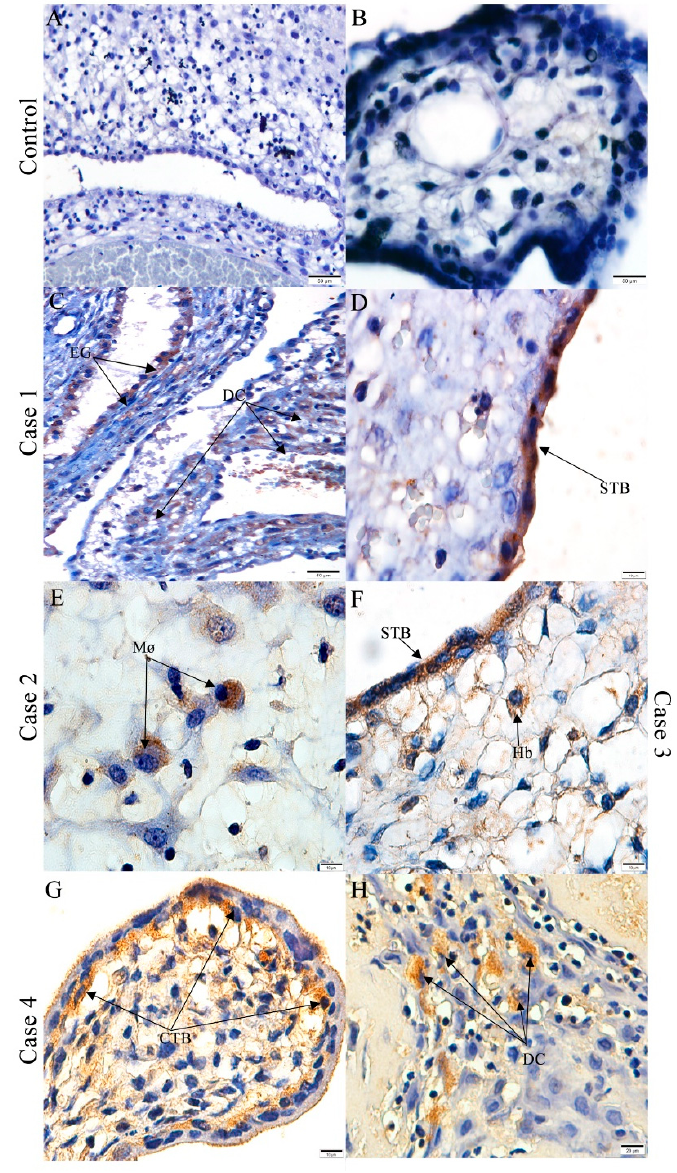
Figure 3. Detection of the chikungunya virus (CHIKV) antigens in aborted materials: Control aborted material without the detection of CHIKV in the ( A ) decidua and ( B ) chorionic villi. CHIKV detection in ( C ) cells of the endometrial glands (EG), decidual cells (DC) and ( D ) syncytiotrophoblasts (STB) of case 1; ( E ) decidual macrophages (Mø) of case 2; ( F ) in the syncytiotrophoblasts and Hofbauer cells (Hb) of case 3 and in ( G ) the cytotrophoblasts and ( H ) decidual cells of case 4. 10 µm = 1000×, 20 µm = 400×, 50 µm= 200×, 100 µm = 100×.